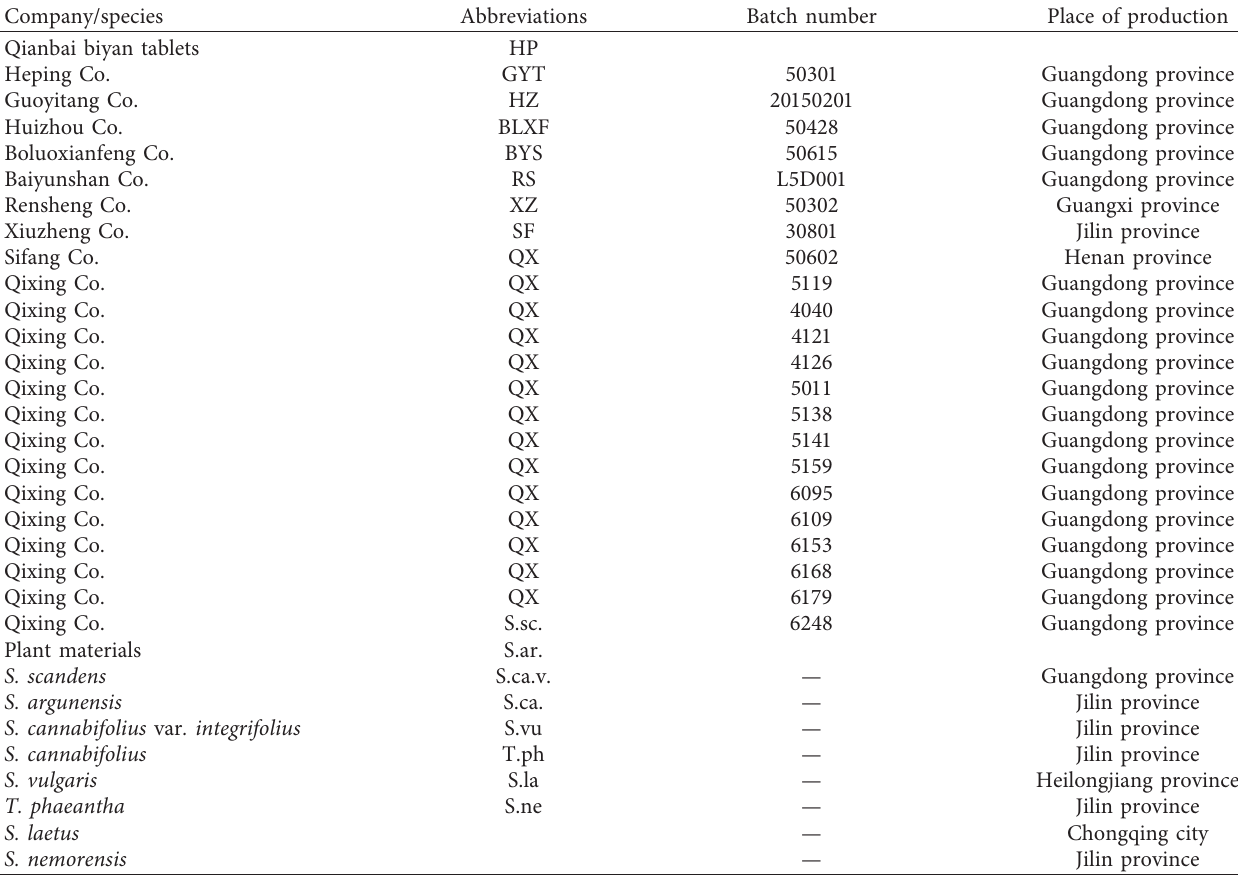
Table 1: Information of QTs and Senecio plants tested in the present